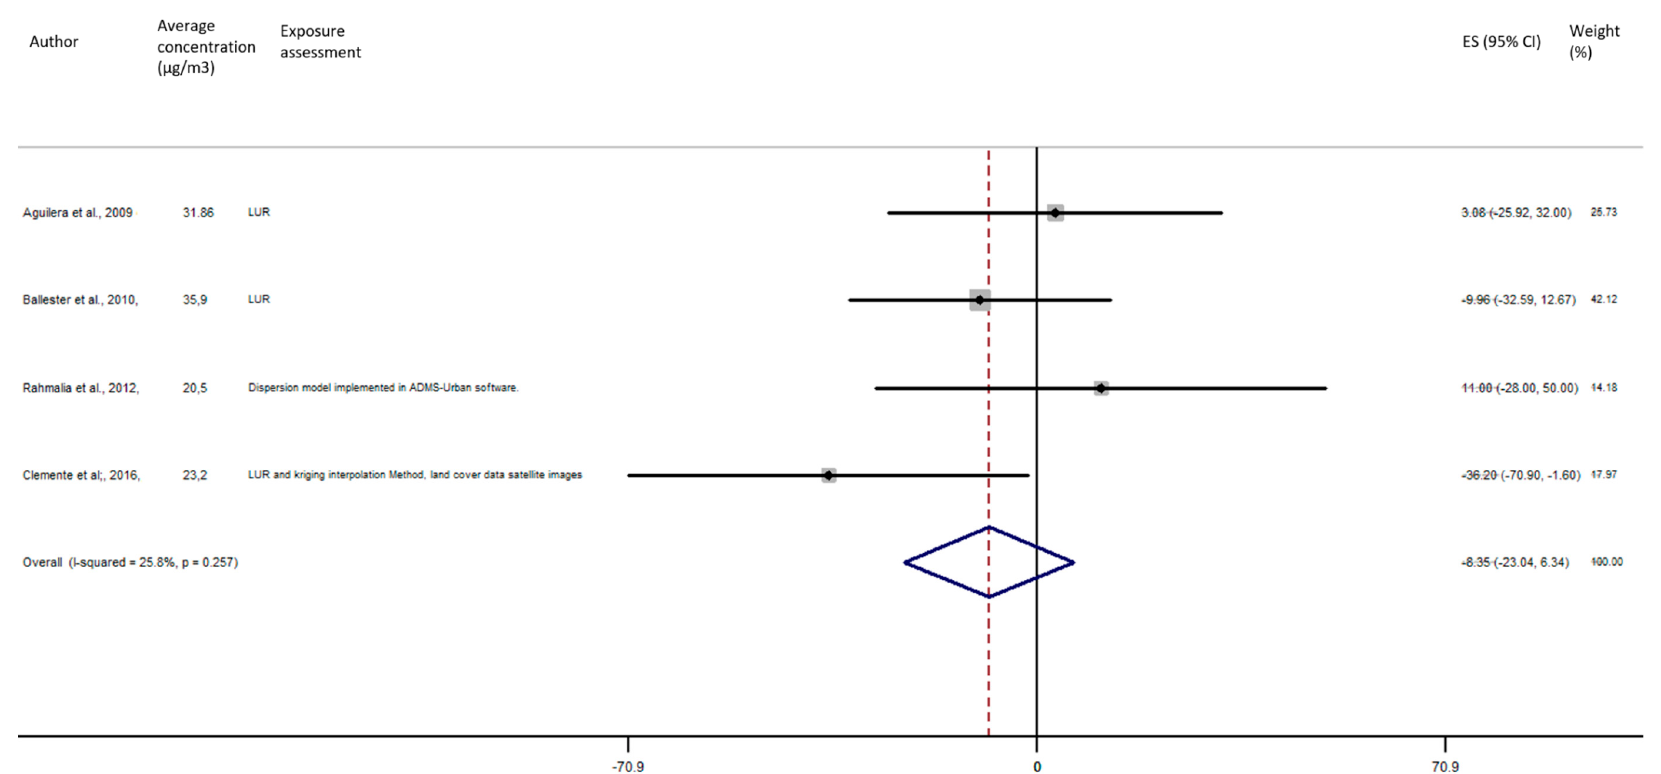
Figure 6. Association between birth weight and NO 2 exposure during the second trimester of pregnancy.